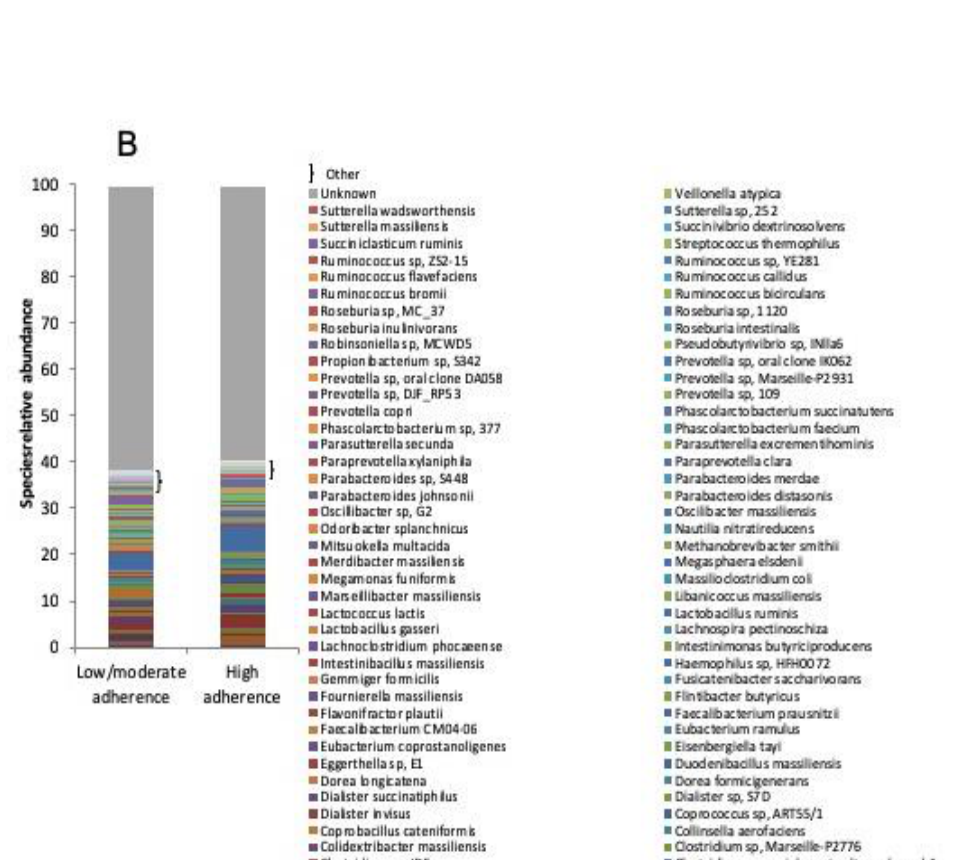
Figure 3. Microbiota composition in low/moderate adherence and high adherence to the Mediterranean diet groups. Mean relative abundance (%) of bacterial genera ( A ) and species ( B ).